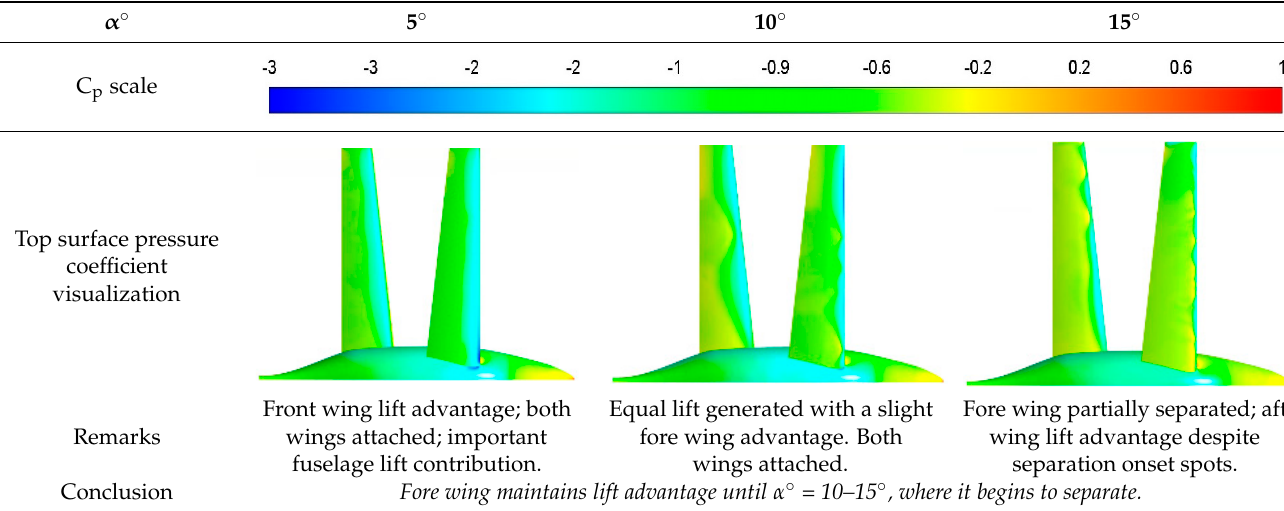
Table 3. Top surface pressure coefficient visualization at different angles of attack and conclusions about flow separation within the linear part of the lift curve (up to 𝛼 о = 15°).